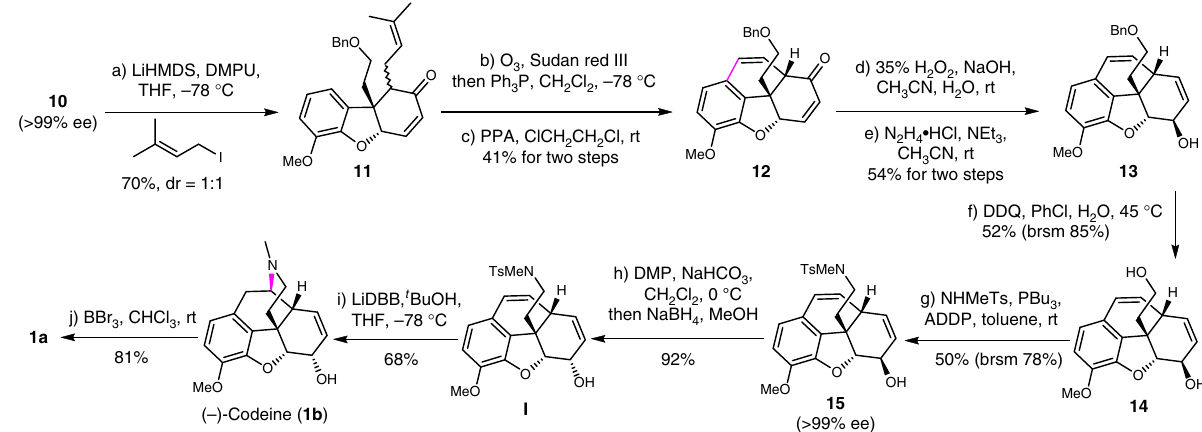
Fig. 5 Asymmetric total synthesis of ( ‒ )-codeine ( 1b ) and ( ‒ )-morphine ( 1a ). The key steps included the Friedel-Crafts reaction, Wharton reaction, Mitsunobu reaction, and hydroamination